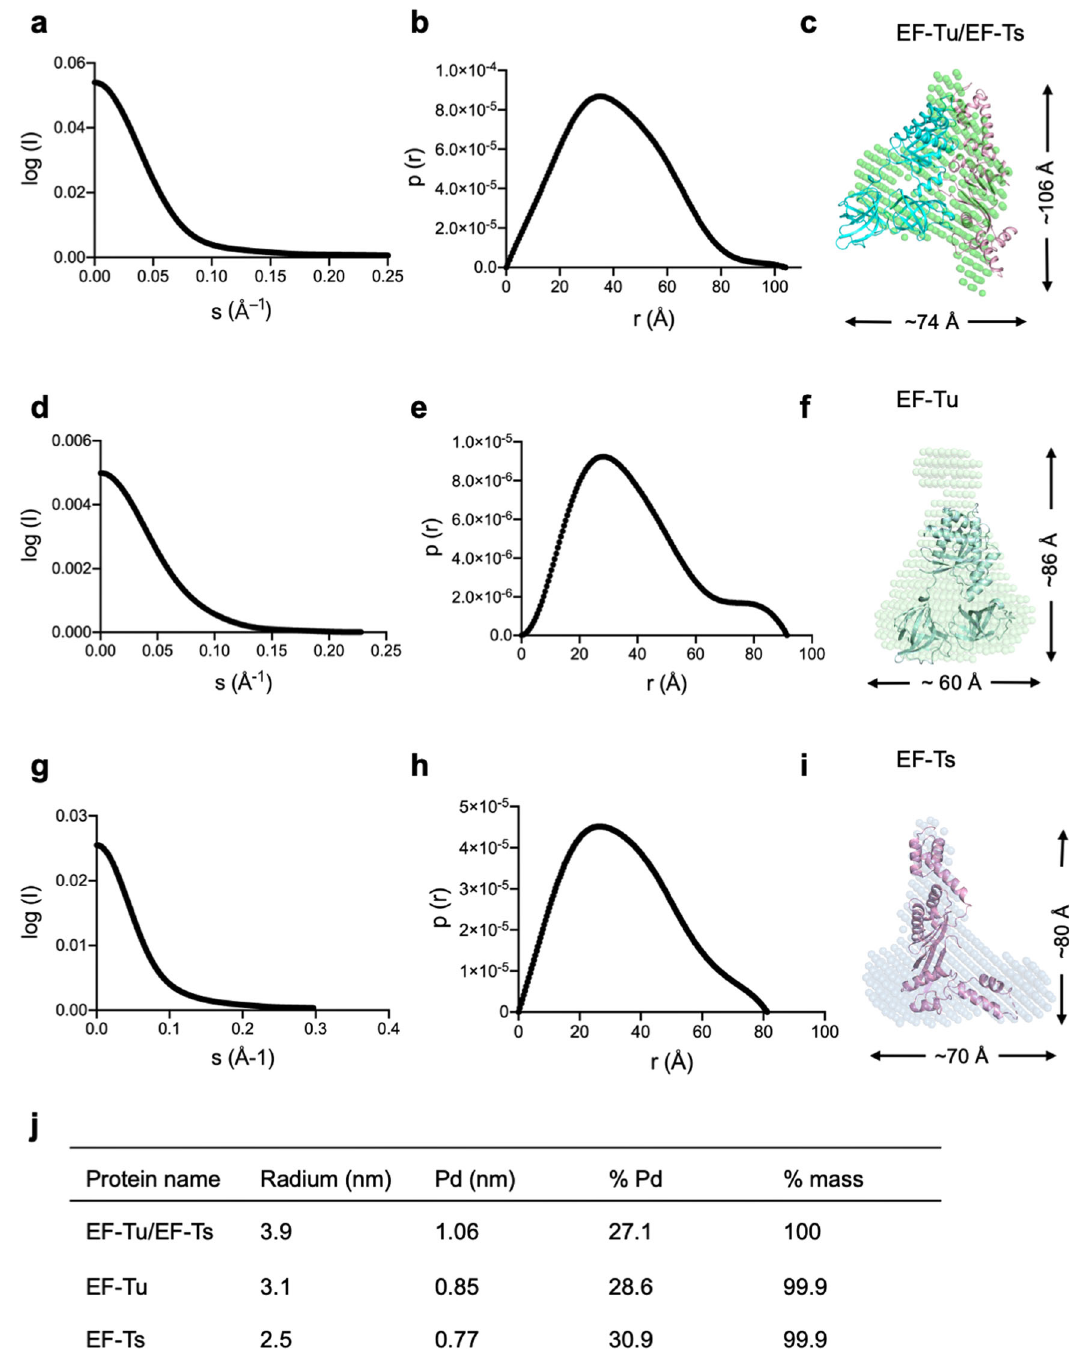
Fig. 5 The SAXS models of the Mtb EF-Tu, EF-Ts, and EF-Tu (cid:129) EF-Ts complex. a The experimental scattering curve of the Mtb EF-Tu (cid:129) EF-Ts complex. b The distance distribution function curve of the EF-Tu (cid:129) EF-Ts complex. c The crystal structure of the EF-Tu (cid:129) EF-Ts complex was fi tted into the ab initio envelope obtained from SAXS. d The experimental scattering curve of Mtb EF-Tu. e The distance distribution function curve of Mtb EF-Tu. f The crystal structure of EF-Tu was fi tted into the ab initio envelope obtained from SAXS. g The experimental scattering curve of Mtb EF-Ts. h The distance distribution function curve of Mtb EF-Ts. i The crystal structure of EF-Ts was fi tted into the ab initio envelope obtained from SAXS. j Dynamic light scattering (DLS) analysis of the Mtb EF-Tu, EF-Ts, and EF-Tu (cid:129) EF-Ts complex. Particle polydispersity was de fi ned in the following terms: polydispersity (Pd), % polydispersity (% Pd). Methods with 25 µg/ml kanamycin and 34µg/ml chloramphenicol at 37 °C. Isopropyl β -D- Protein expression and puri fi cation . The full-length EF-Tu (Uniprot ID: 1-thiogalactopyranoside (IPTG, 0.2mM) was added to cells to induce protein expression at 20 °C for 18h when the OD 600 reached 0.6 – 0.8. Then, the cells were P9WNN1) and EF-Ts (Uniprot ID: P9WNM1) were subcloned from the Mtb harvested by centrifugation at 6000 rpm for 15 min at 4°C. The cell pellets were genomic library into the pSMT3 vector with a His-SUMO tag. The wild-type and resuspended in a lysis buffer (Tris-HCl pH 8.0, 100 mM NaCl, 10mM imidazole mutants of EF-Tu and EF-Ts plasmids were transformed into E. coli BL21 (DE3) or pH 8.0, 5% glycerol, 4 mM MgCl 2 , and 2mM β -mercaptoethanol) and disrupted Rosetta (DE3) cells for protein expression. E. coli cells were cultured in LB medium COMMUNICATIONS BIOLOGY| (2022) 5:1052